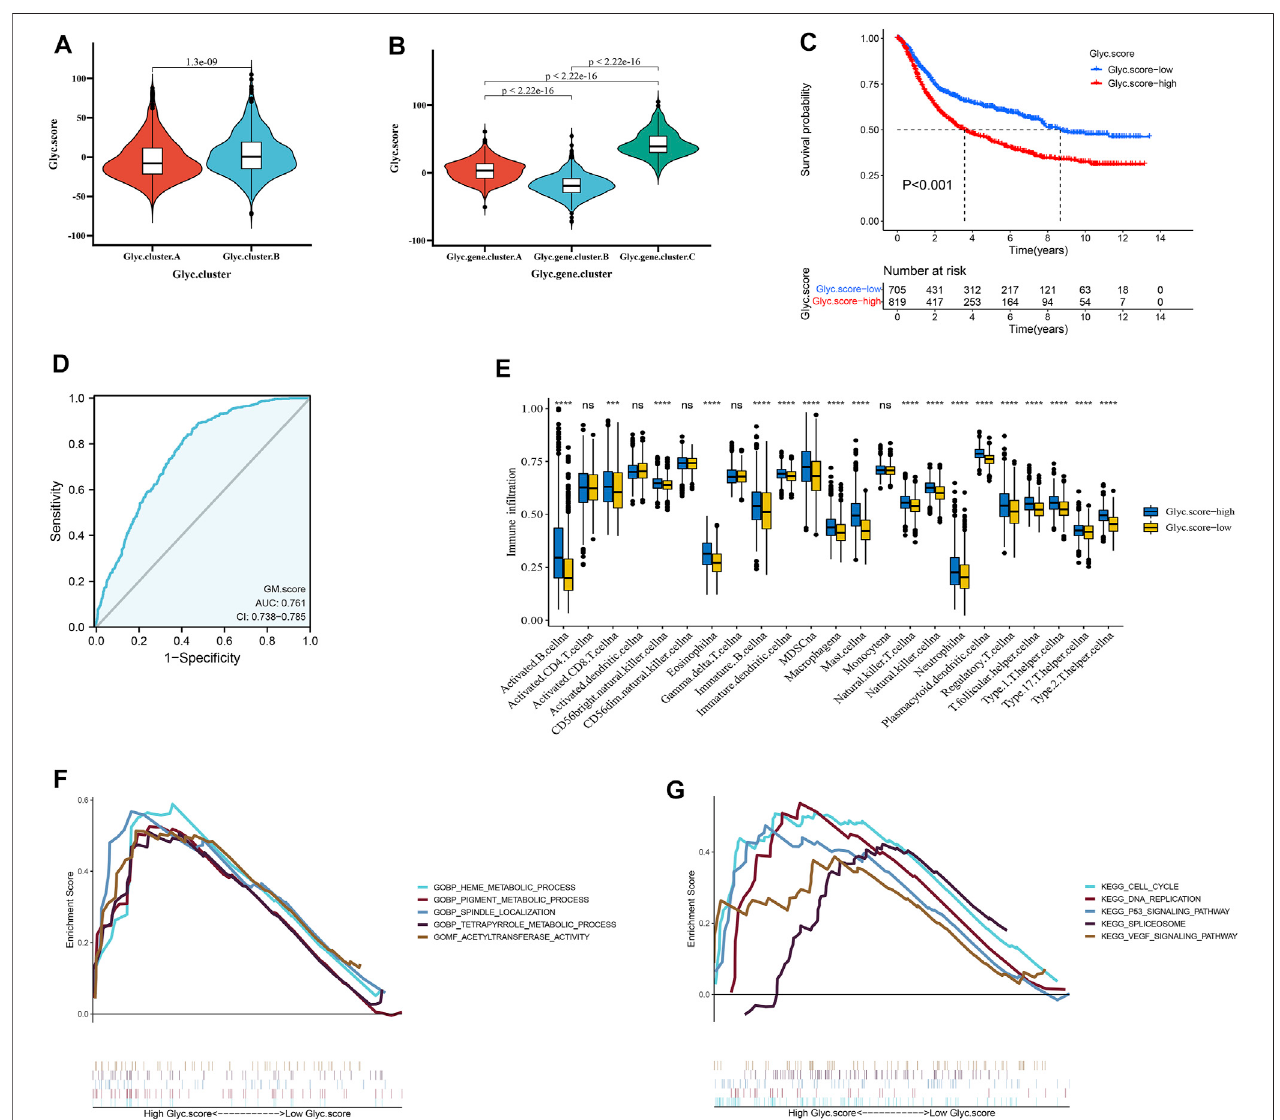
FIGURE 5 | Construction of Glyc. score. (A) Differences in Glyc. score among two Glyc. clusters in meta cohort. (B) Differences in Glyc. score among three Glyc. gene.clusters in meta cohort. (C) Kaplan – Meier curves for high – and low – Glyc. score patient groups. (D) The predictive value of Glyc. score in meta cohort. (E) The abundance of each TME in fi ltrating cell in high – and low – Glyc. score groups. The upper and lower ends of the boxes represented the interquartile range of values. The linesintheboxesrepresentedmedianvalue,andblackdotsshowedoutliers. (F) GSEAGOidenti fi edhigh – andlow – Glyc.scoregroupsrelatedsignalingpathways in gastric cancer. (G) GSEA KEGG identi fi ed high and low Glyc. score – related signaling pathways in gastric cancer.